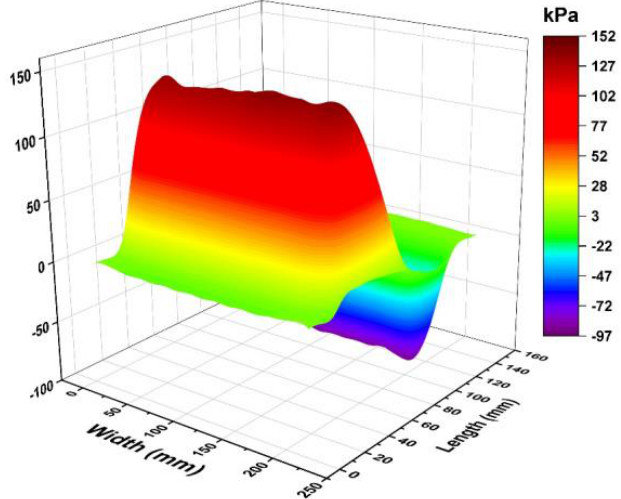
Figure 8. Longitudinal stress distribution in the tire contact surface.